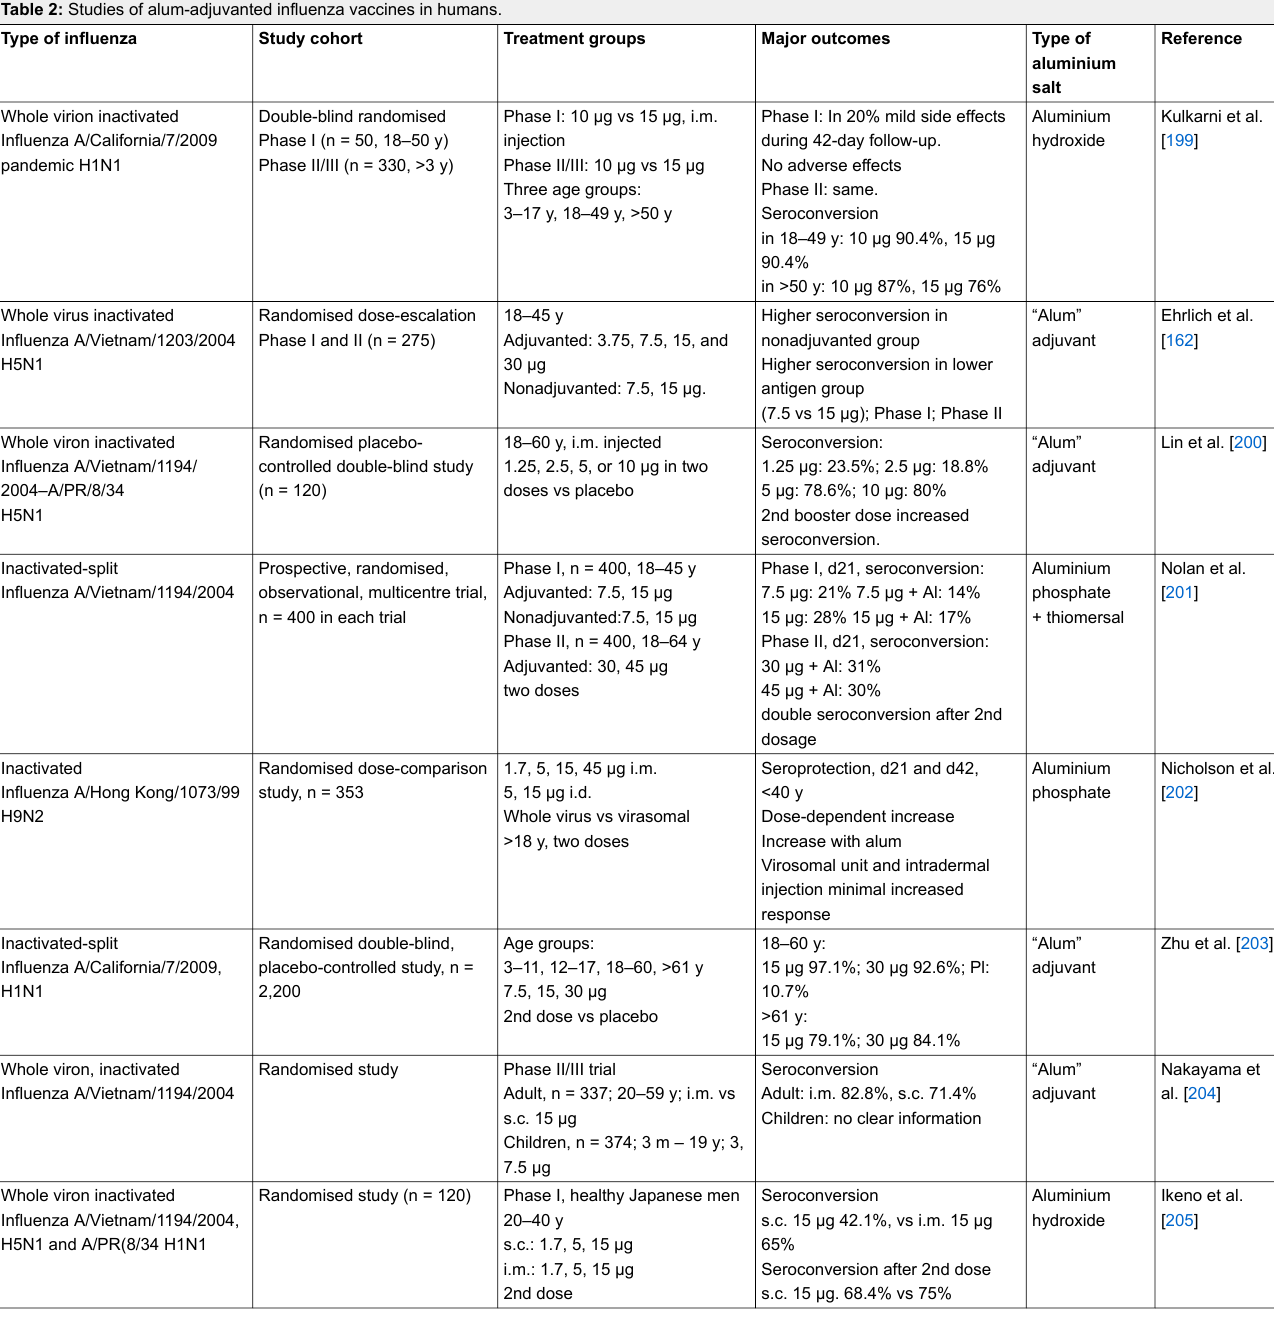
Table 2: Studies of alum-adjuvanted influenza vaccines in humans. Type of